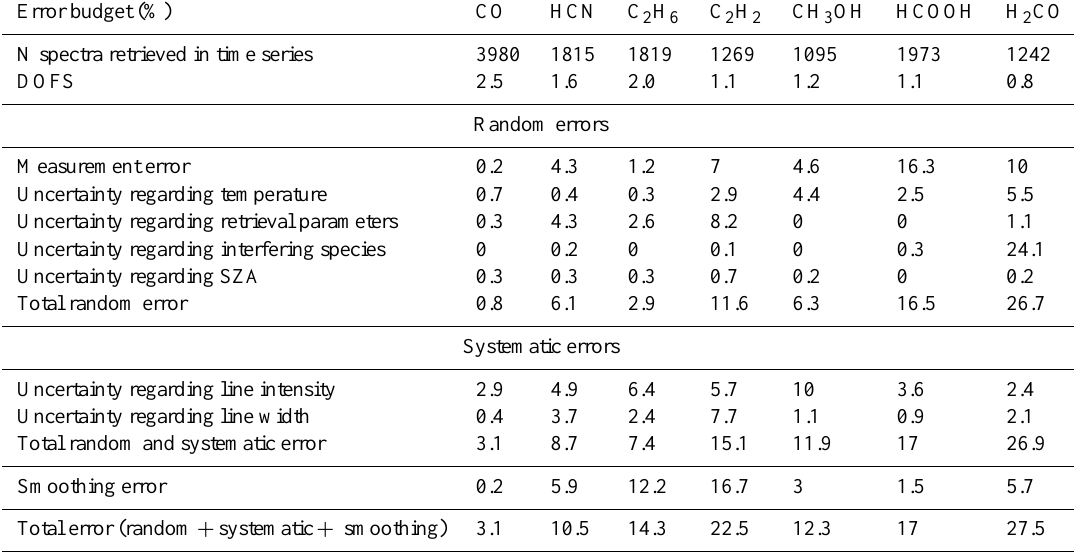
Table 3. Error budgets, in percentage, as a function of the different sources of random and systematic uncertainties regarding typical CO, HCN, C 2 H 6 , C 2 H 2 , CH 3 OH, HCOOH and H 2 CO total columns retrieved at PEARL. DOFS and SZA are the acronyms of degrees of freedom for signal and solar zenith angle,